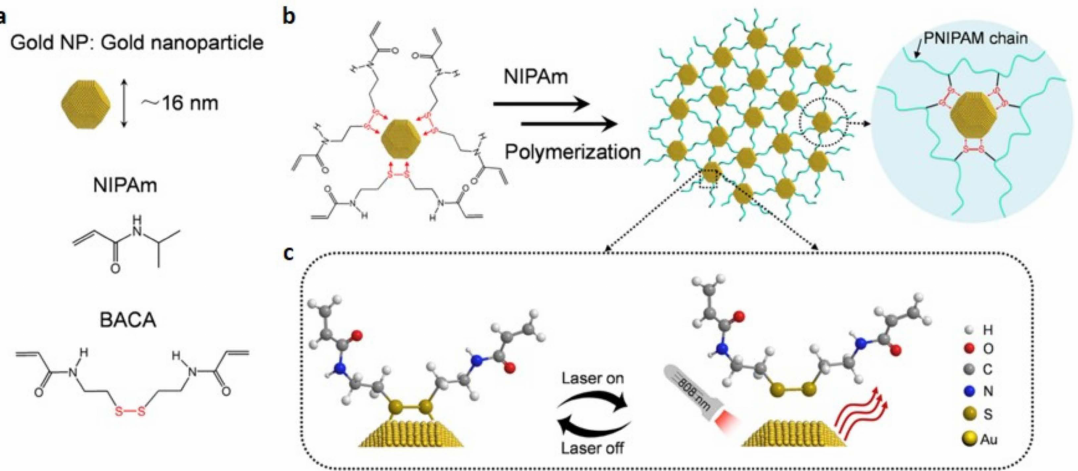
Figure 1. Schematic Illustrations of Gold-Thiolate Interaction-Triggered Self-Healing Nanocomposite Hydrogels ( a ) Schematic structure of gold NPs and a list of co-monomers used for polymerization of hydrogels. ( b ) Schematic formation of GNP hydrogel with modified gold NPs as large crosslinkers in the in situ free-radical polymerization. ( c ) Schematic mechanism for dynamic and reversible RS–Au bonding with NIR laser irradiation (808 nm) [22]. Copyright Elsevier,